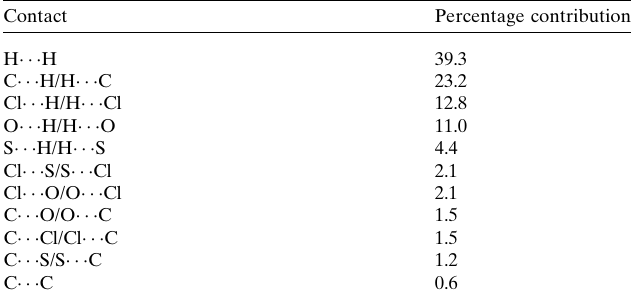
Table 3 Percentage contributions of interatomic contacts to the Hirshfeld surface for